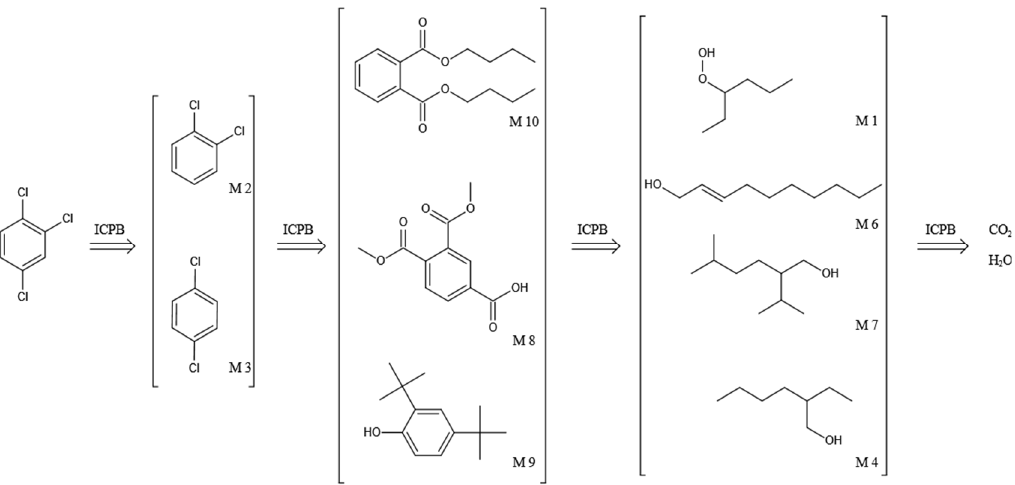
Figure 8. Degradation pathway of